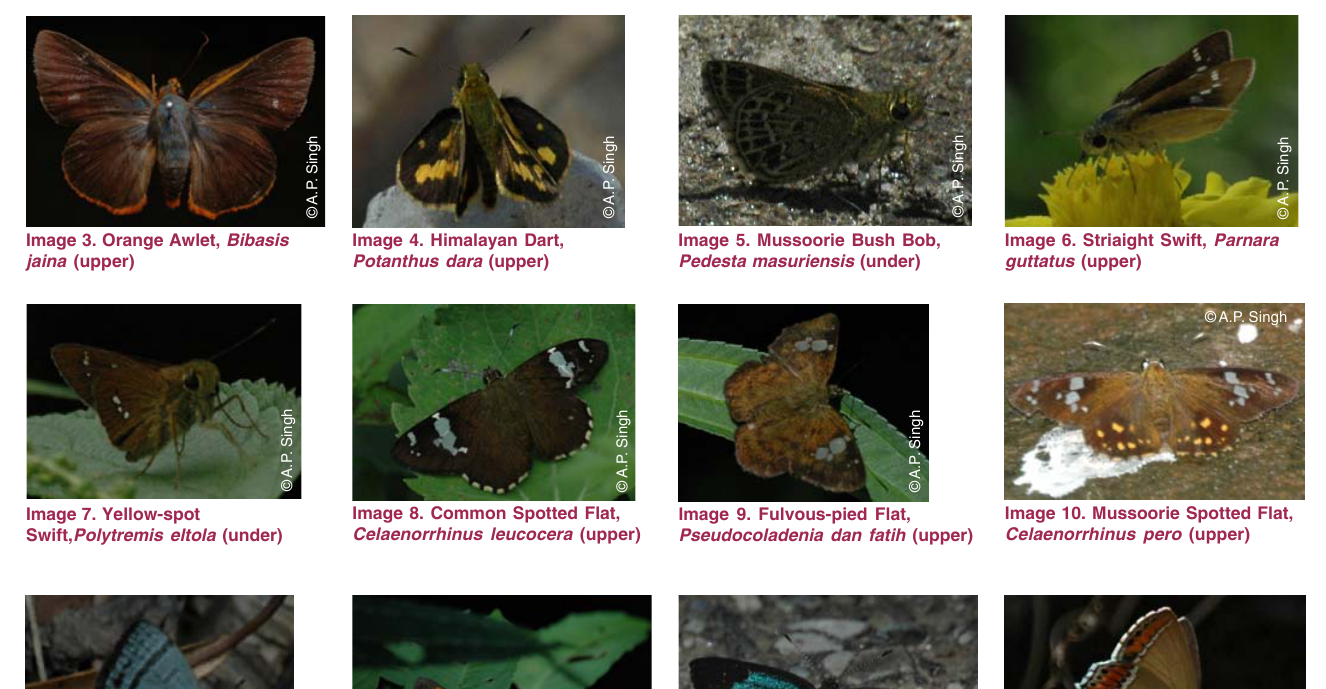
(upper)Image 11. White Spotted Hairstreak Euaspa ziha (under)